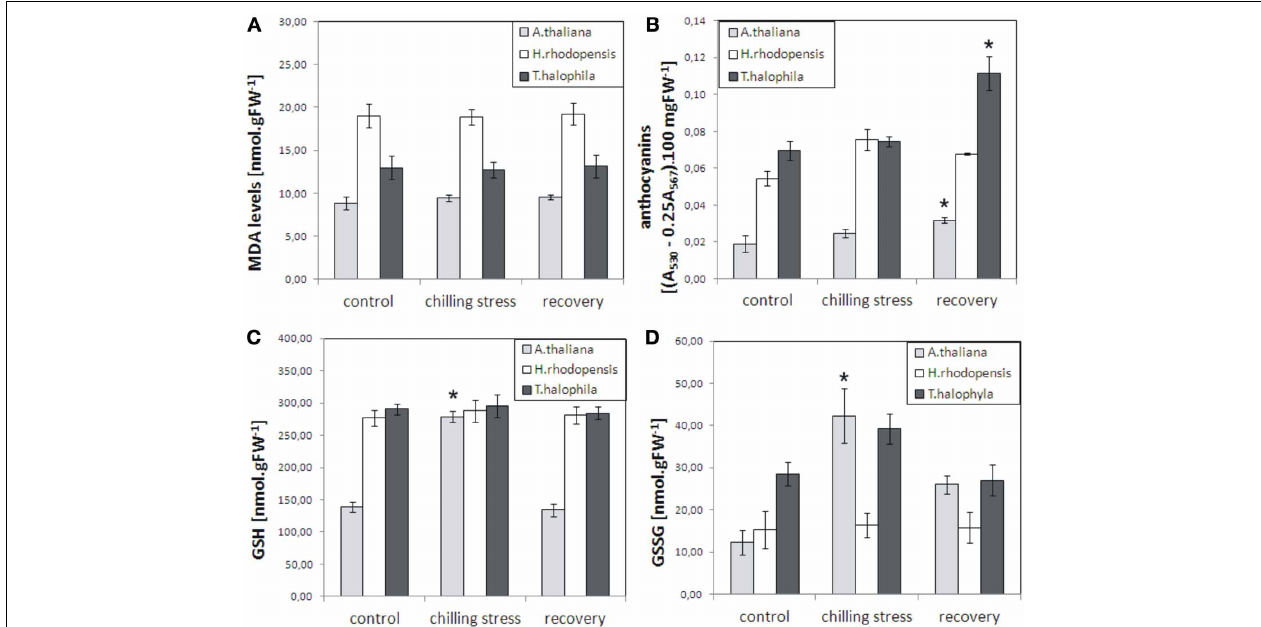
recovery. (A) , MDA content; (B) , anthocyanins; (C) , GSH levels; (D) , GSSG levels. MDA, GSH, and GSSG are expressed as nmol per gram fresh weight (FW), while anthocyanins are presented as the difference in absorbencies between 530 and 567nm (A 530 − 0 . 25 A 567 ) per 100mg fresh weight. Asterisks indicate significant difference between controls and low temperature-treated or recovered plants ( P ≤ 0 . 05, student’s t -test). The data are means ± s.e.m. of three